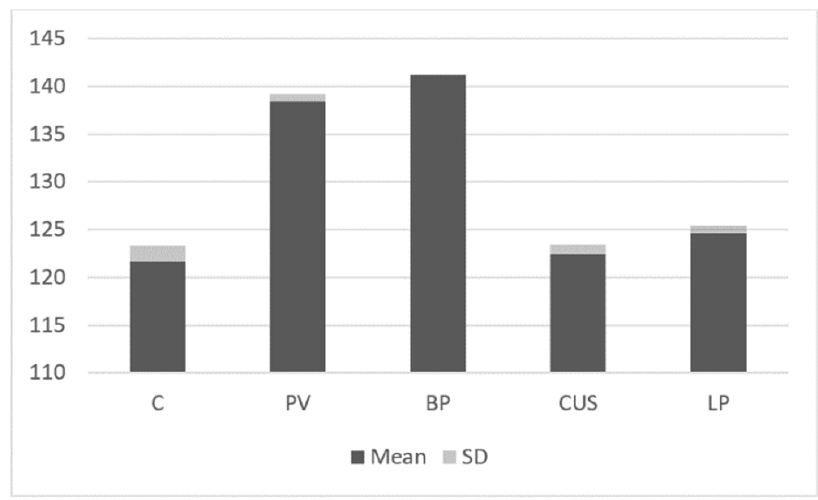
Figure 6. Immunoblotting. STAT4 expression in studies groups and control group. The expression of STAT6 protein was significantly higher in PV patients (131.37 ± 2.55), BP patients (129.34 ± 1.37) and LP (130.56 ± 1.76) as compared to the control group (123.48 ± 1.13; p < 0.05). There was no statistical difference in the expression of STAT6 in CUS patients vs. control group (Figure 7).